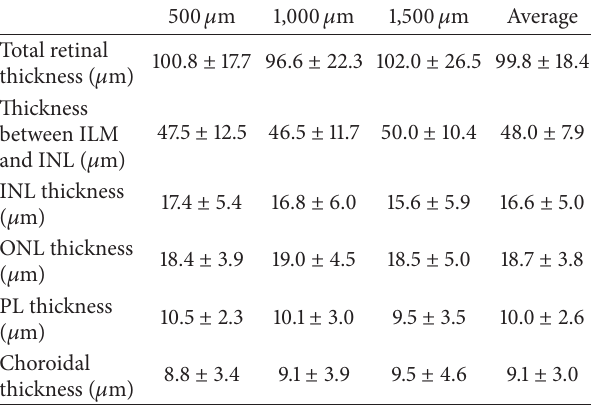
Table 1: The mean retinal and choroidal thicknesses in the normal SD rats. Each value is based on the distance from the optic nerve disc (500, 1,000, and 1,500 𝜇 m). The average of the three values is calculated.